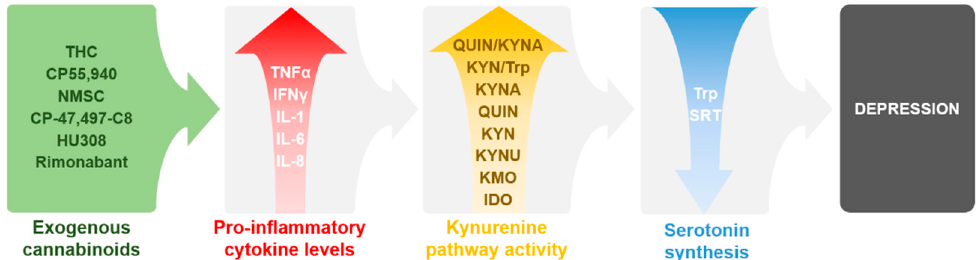
Figure 2. Summary of the reviewed data and their proposed connections between exogenous cannabinoids, pro-inflammatory cytokines, KP, and depression as discussed in the sections below and in Tables 1 and 2. Abbreviations: IDO: indolamine 2,3-dioxygenase; IFN γ : interferon γ ; IL: interleu- kin; KMO: kynurenine 3-monooxygenase, KYN: L -kynurenine, KYNA: kynurenic acid; QUIN: quin- olinic acid; THC: ∆ 9 -tetrahydrocannabinol; TNF α : tumor necrosis factor α ; Trp: tryptophan; SRT: serotonin.